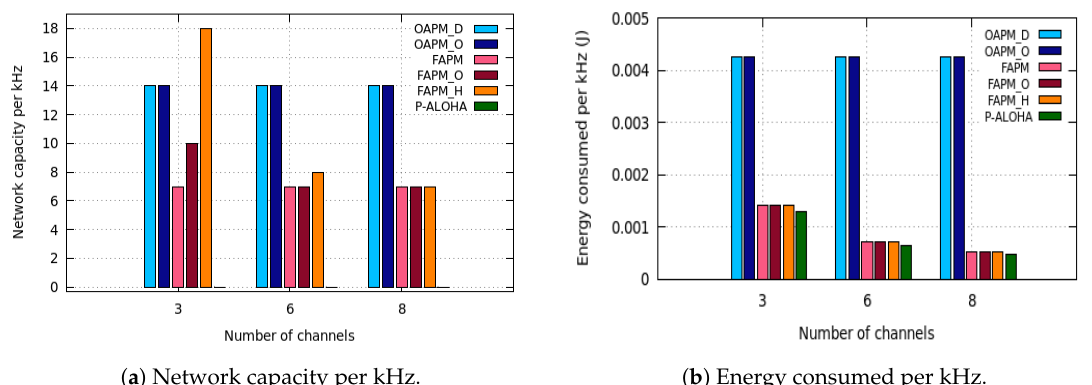
Figure 16. Comparison of Pure Aloha, the OAPM family and the FAPM family.